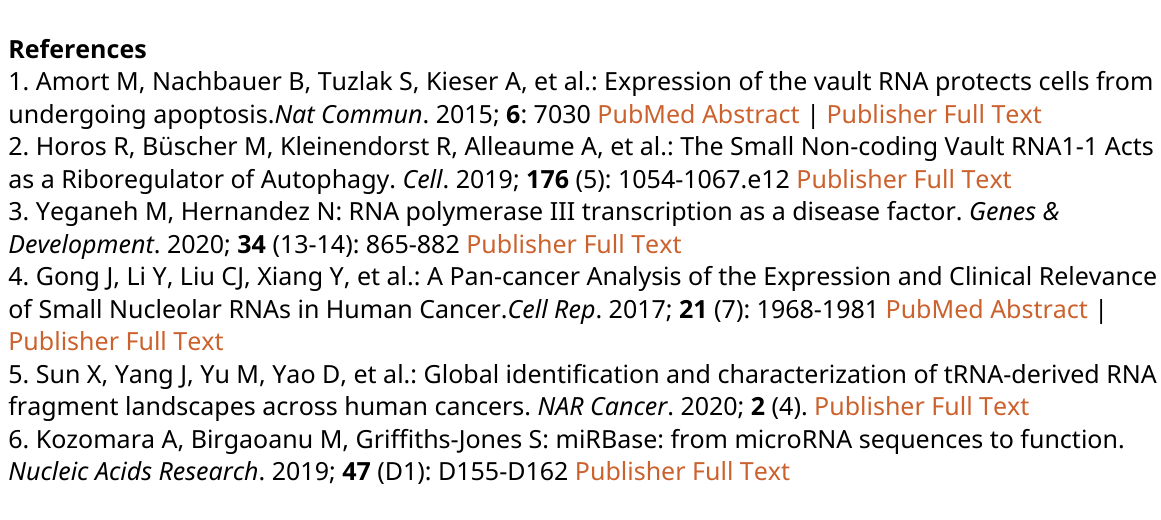
Page 3: “…the presence of silencing mutations at the B box element of its promoter B-box”.